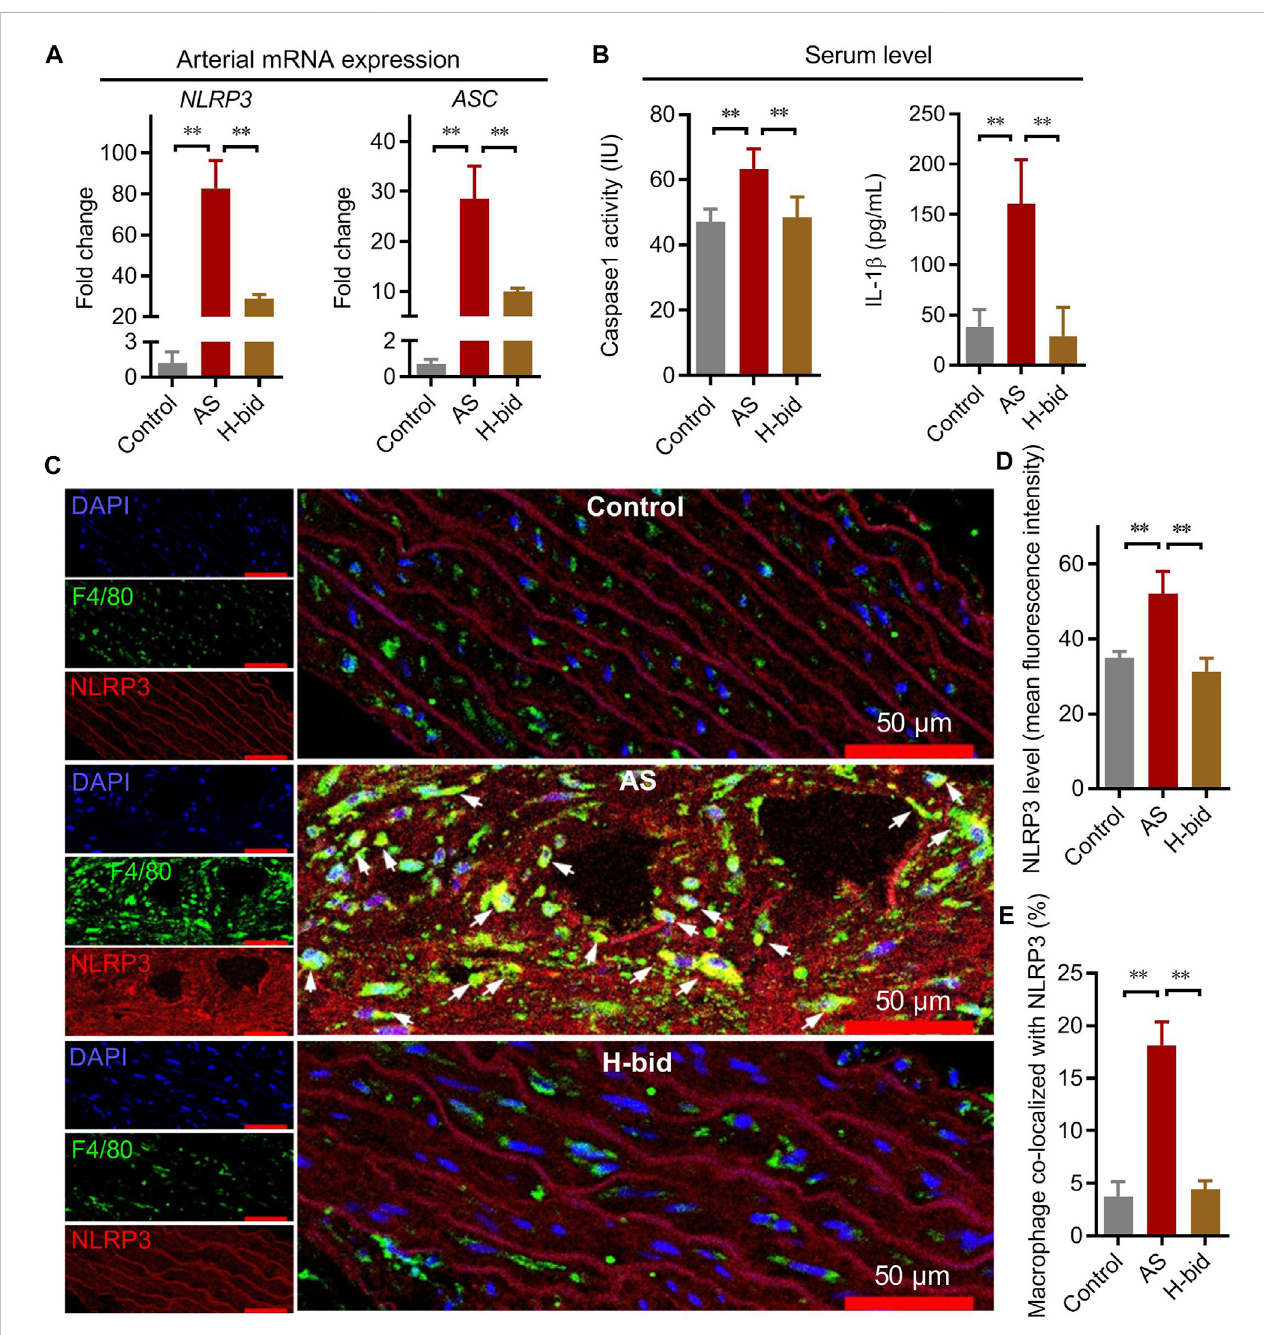
FIGURE 4 Art inhibits arterial NLRP3 in fl ammasome activation in AS rats. (A) mRNA expression of NLRP3 and ASC in aortas from AS rats detected by real-time PCR ( n = 4). (B) Serum levels of caspase-1 and IL-1 β in AS rats detected by ELISA ( n = 5). (C) Immuno fl uorescence staining of arterial sections. Experiments were performed as described in Figure 3A, using antibodies against F4/80 (green) or NLRP3 (red), followed by DAPI (blue) staining. The white arrows indicate the macrophages co-located with NLRP3. (D – E) Confocal images were analyzed by ImageJ; the arterial NLRP3 expression and colocalization of macrophages with NLRP3 were calculated, respectively ( n = 5). * p < 0.05; ** p <